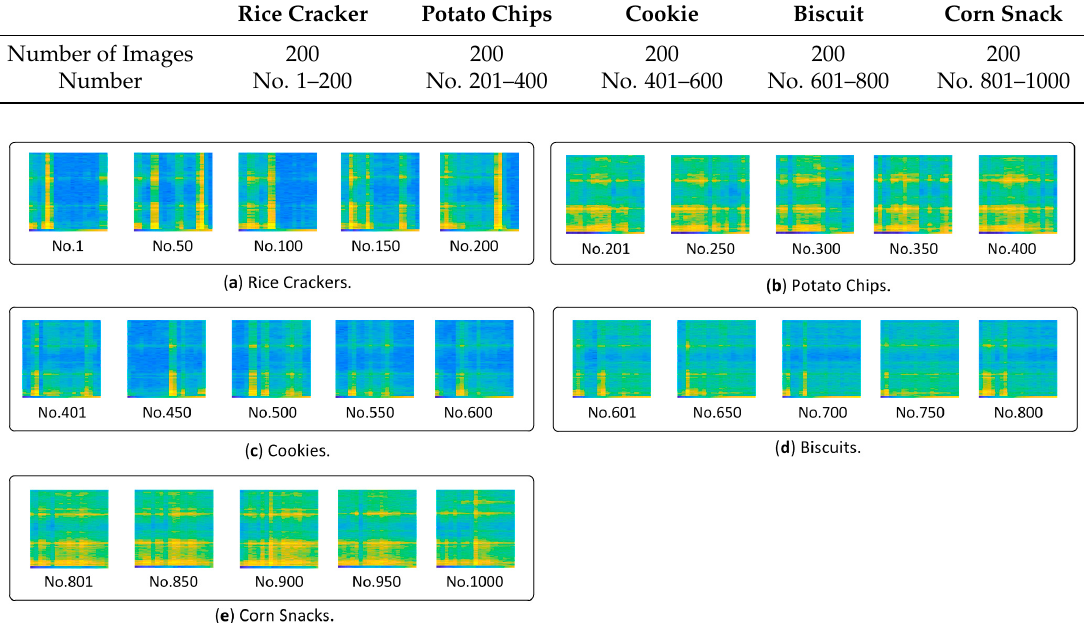
Table 4. Snack image information.